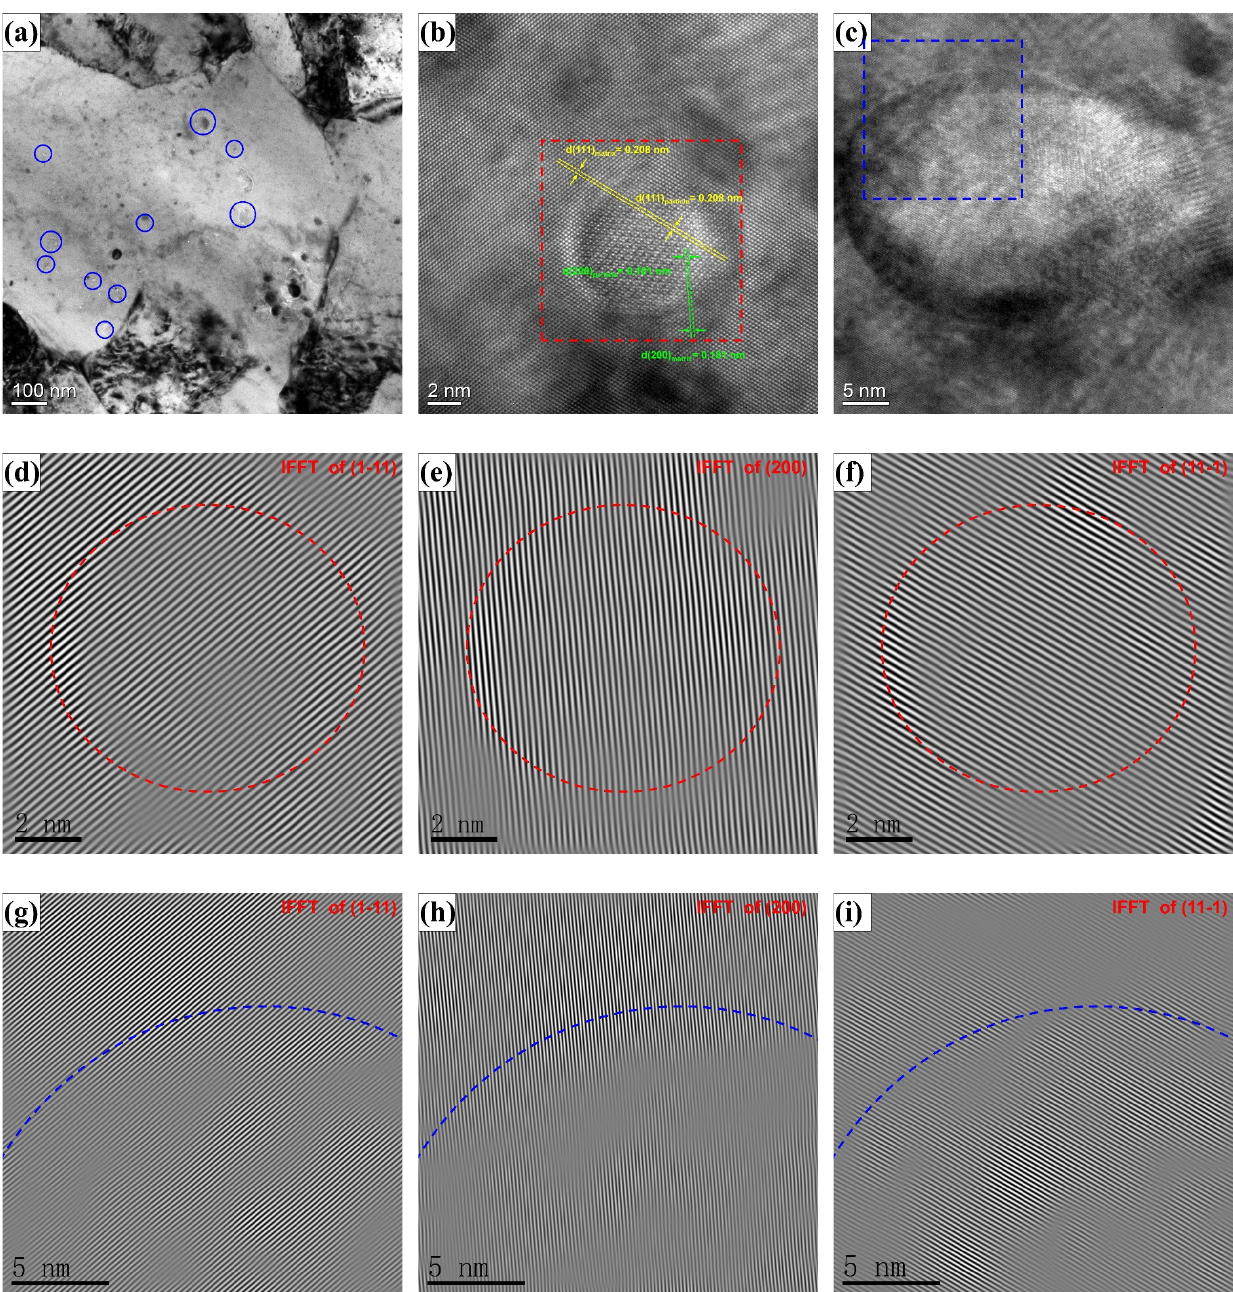
Figure 8. ( a ) BF image of the alloy annealed at 800 ◦ C with high-density nanoparticles in the matrix; ( b ) HRTEM image of the alloy annealed at 800 ◦ C, including a nanoparticle with a diameter of about 9 nm; ( c ) HRTEM image of the alloy annealed at 800 ◦ C, including a nanoparticle with a diameter of about 30 nm; ( d – f ) IFFT images of red square region in ( b ) on (1-11), (200) and (11-1), respectively; ( g – i ) IFFT images of blue square region in ( c ) on (1-11), (200) and (11-1), respectively.